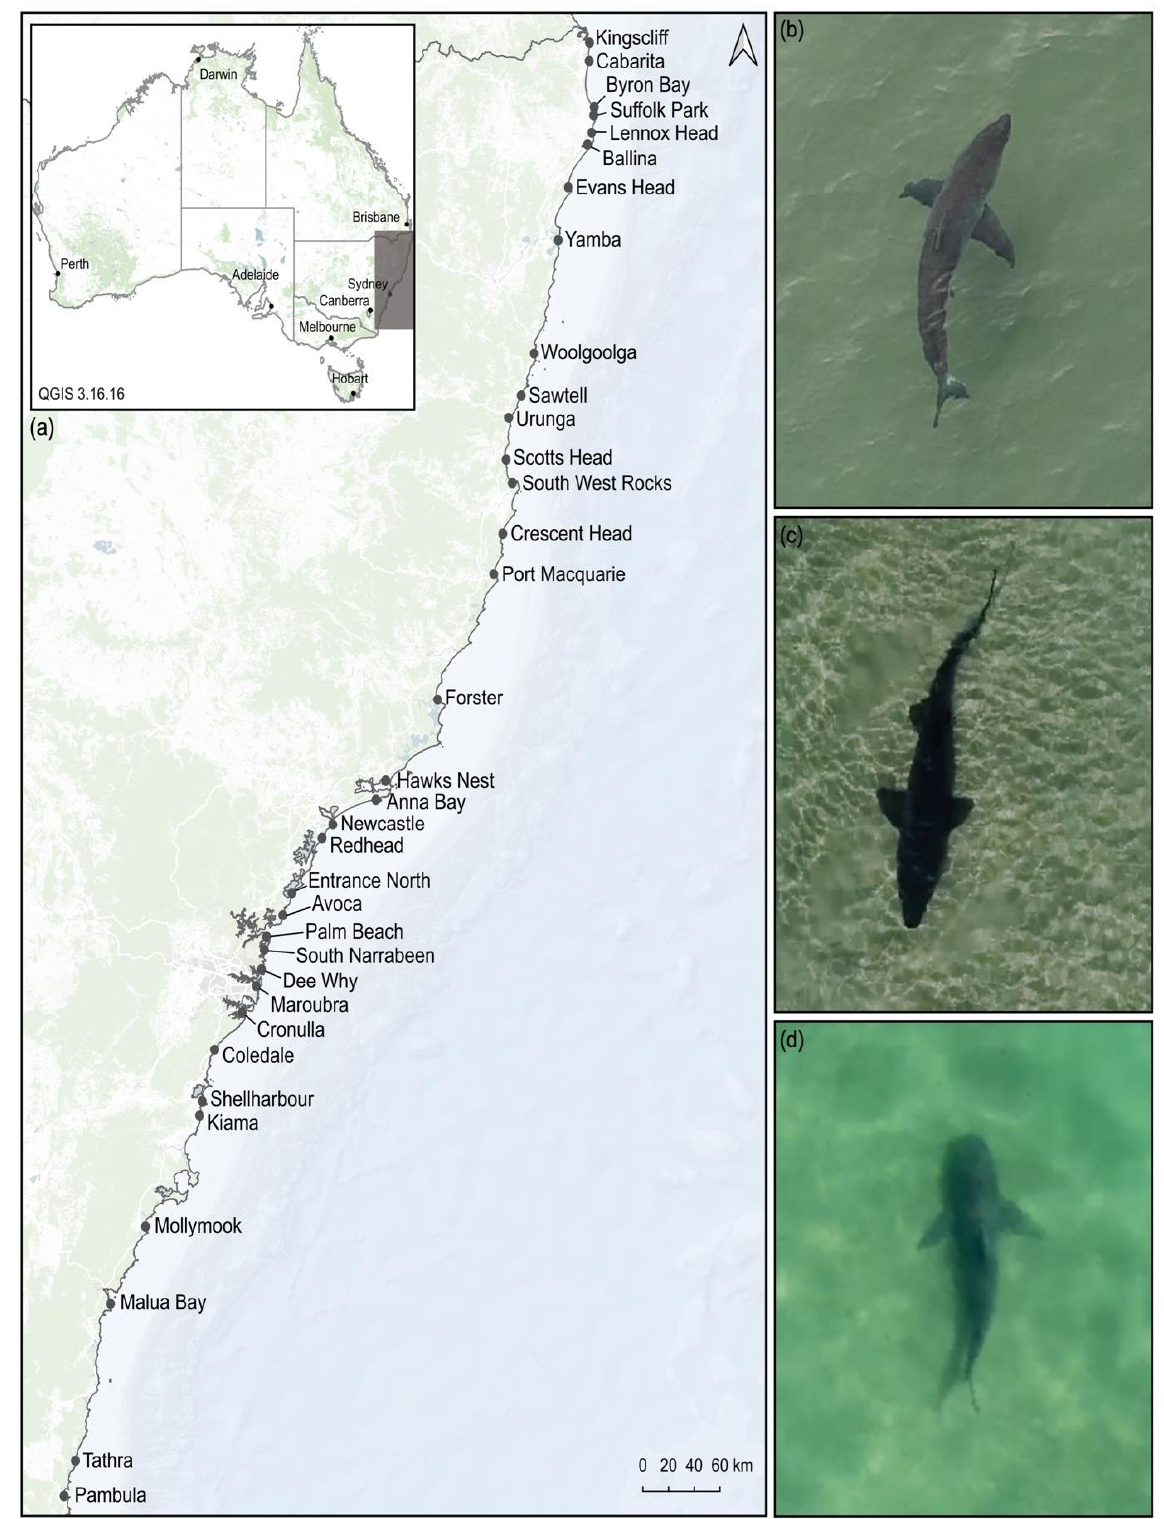
Figure 1. ( a ) Locations of beaches studied using drone surveying techniques along the coastline of New South Wales, Australia. Examples of shark species observed using drones (( b ) a white shark ( Carcharodon carcharias ); ( c ) a greynurse shark ( Carcharias taurus ); and ( d ) a bull shark ( Carcharhinus leucas )) during the study.